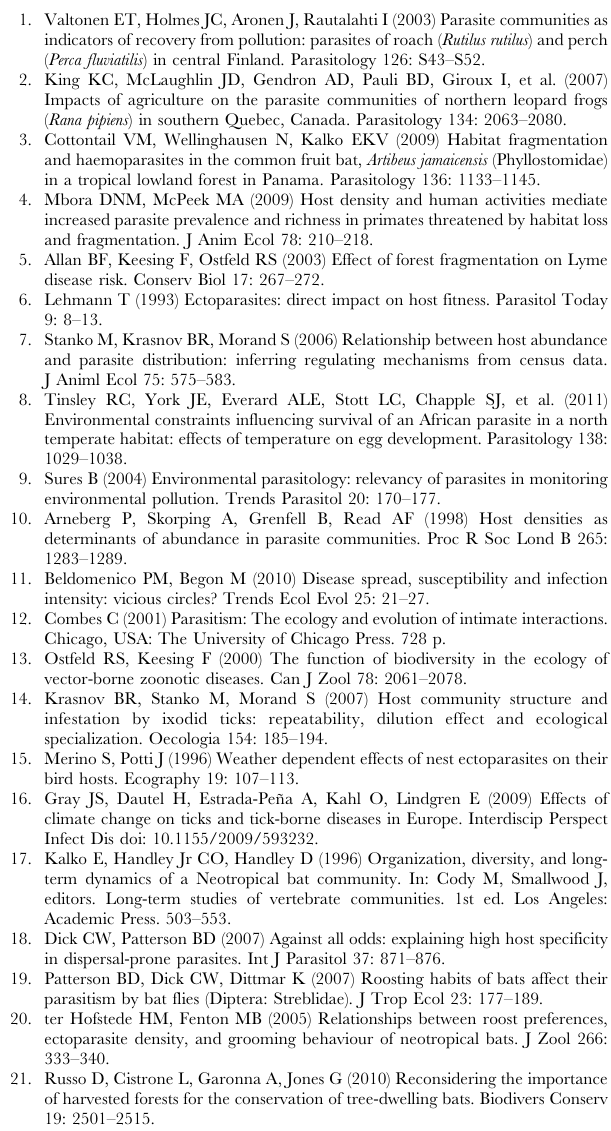
Table S2 Comparison of models used to test the effect of climate and disturbance on fly abundance per host species in four species of bats in the Smithsonian Venezuela Project data set. Protocol S1 Detailed description of the zero-inflated negative binomial statistical